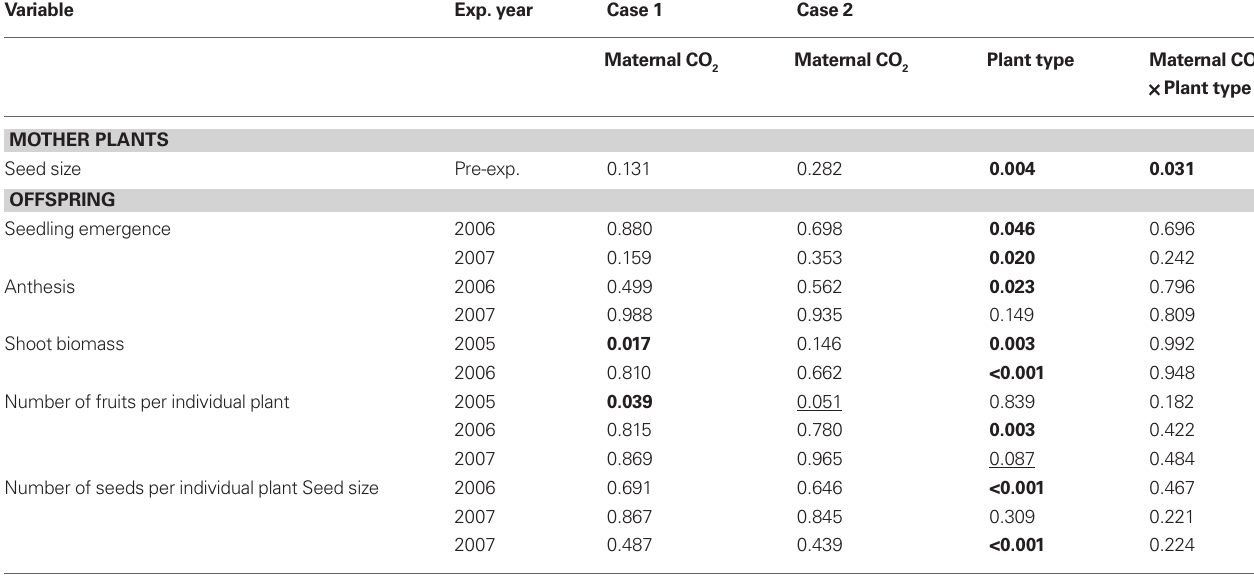
Table 3 | Probability ( P ) values from mixed-model AnOVA of the size of seeds developed on mother plants and of performance of offspring. Variable